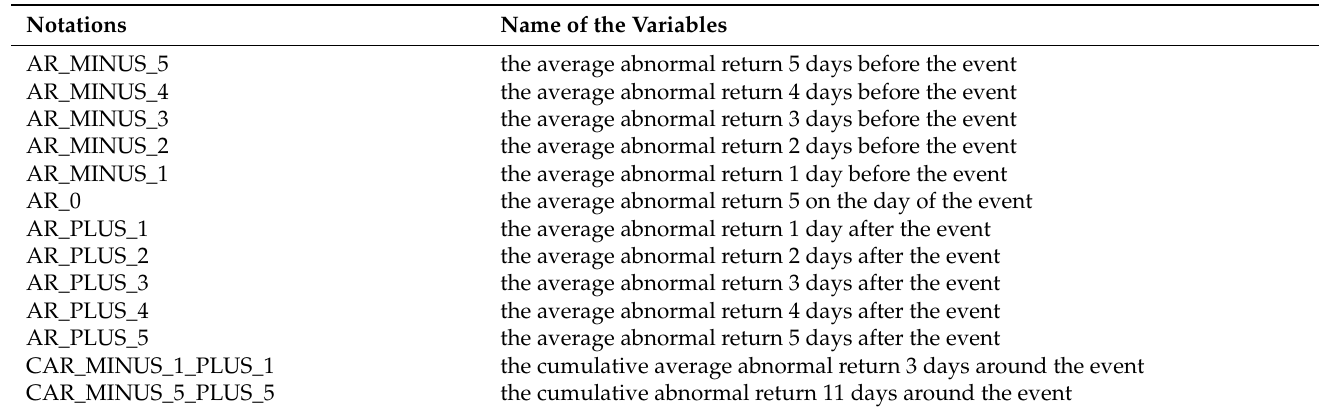
Table 1. Name of variables and Notations.